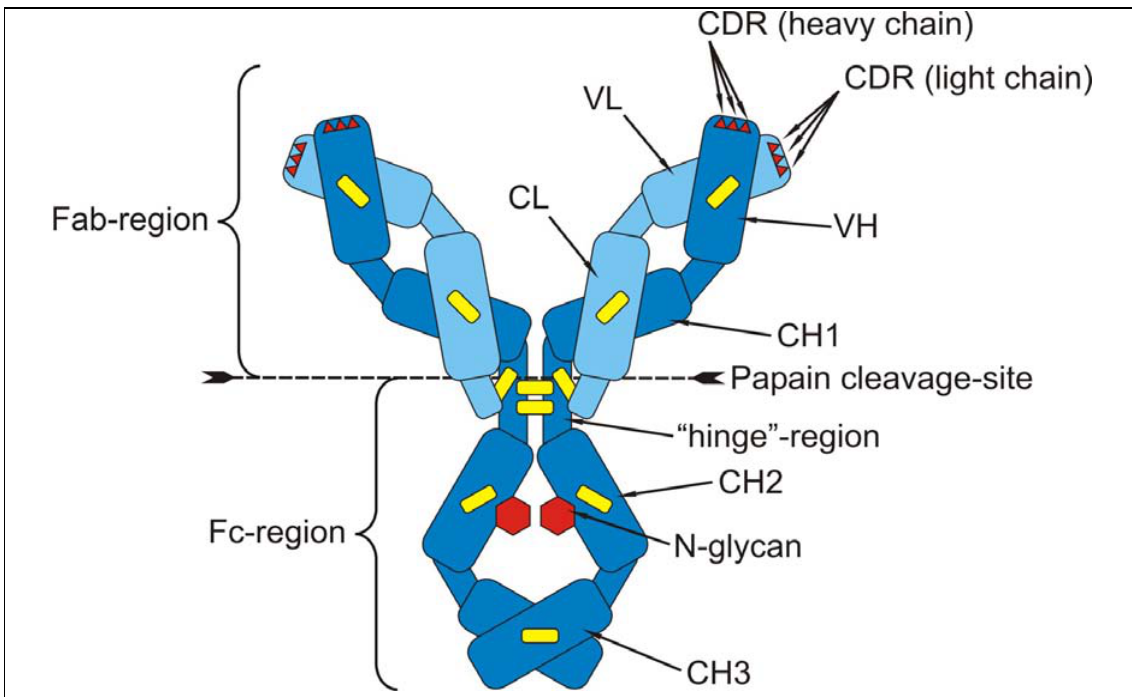
Figure 3. Schematic representation of a fully assembled, monomeric IgG1 molecule. The molecules heavy- chains are indicated in dark-blue; the light-chains are indicated in light-blue; inter-chain disulfide bonds are highlighted in yellow; complementarity-determining regions (CDR) are highlighted by red triangles.